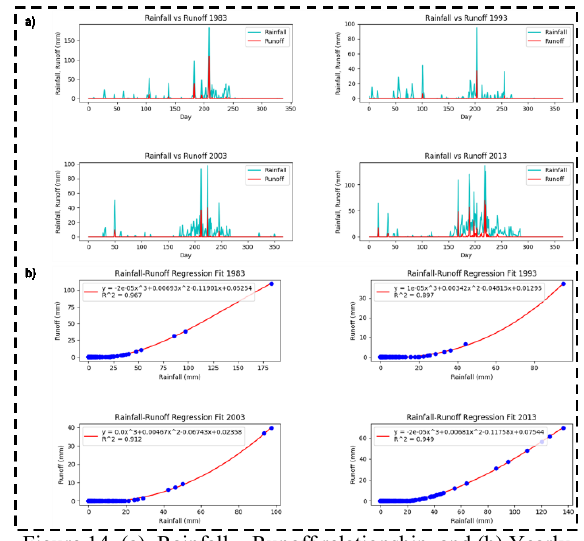
Figure 14. (a) Rainfall – Runoff relationship, and (b) Yearly Rainfall – Runoff plot for Decadal